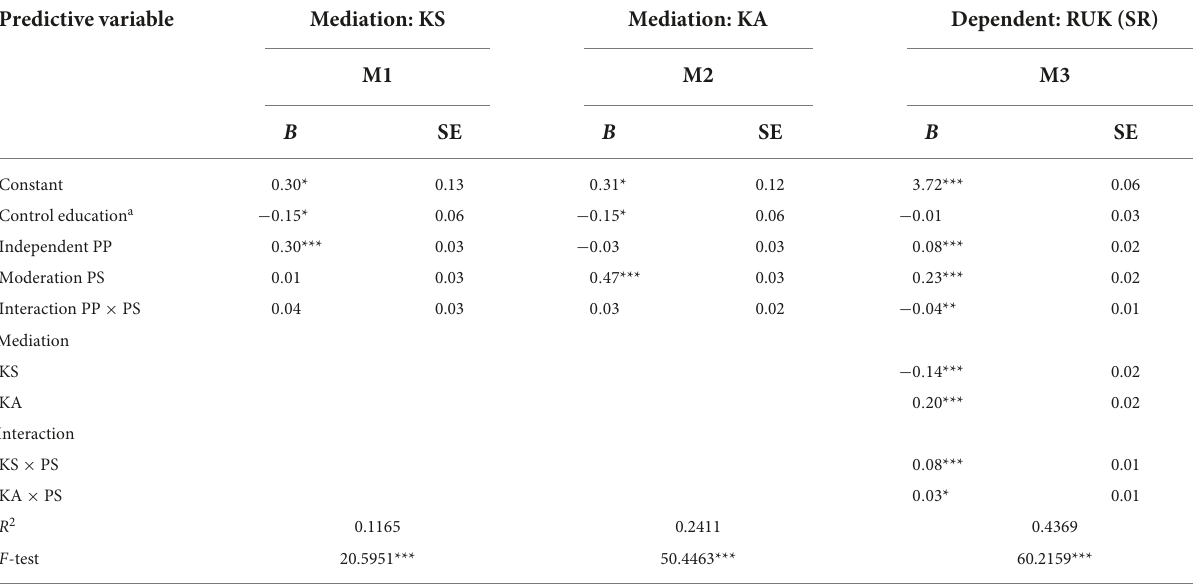
TABLE 5 Analysis of the moderating effect of political skills to partner protectiveness on receiving useful knowledge (self-report).